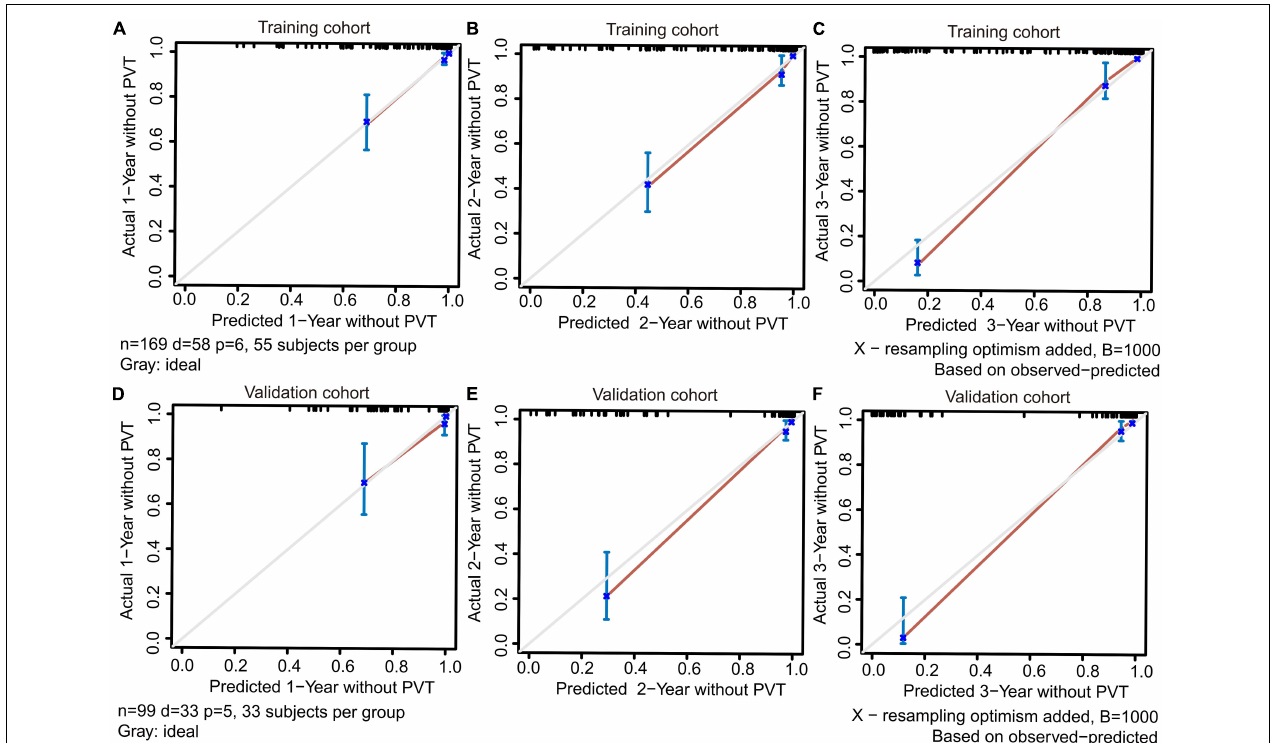
FIGURE 4 | The calibration curves for predicting PVT at 1, 2, and 3-year in the training (A–C) and validation (D–F) cohorts. Perfect prediction would correspond to a slope of 1 (diagonal 45-degree gray line).